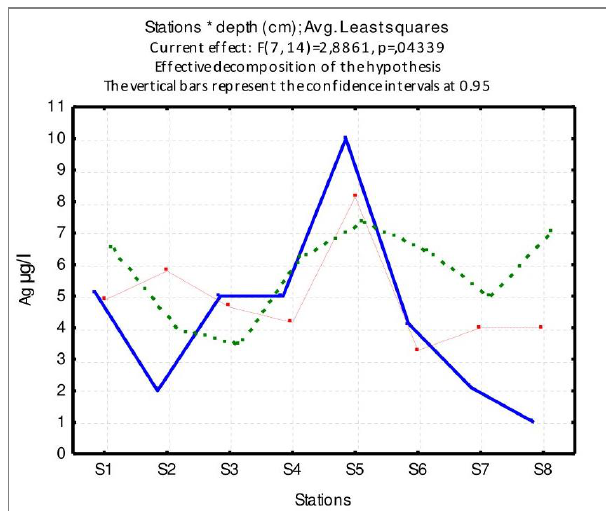
Figure 15 Spatial variation of Ag in μg/l in Reghaia lake.